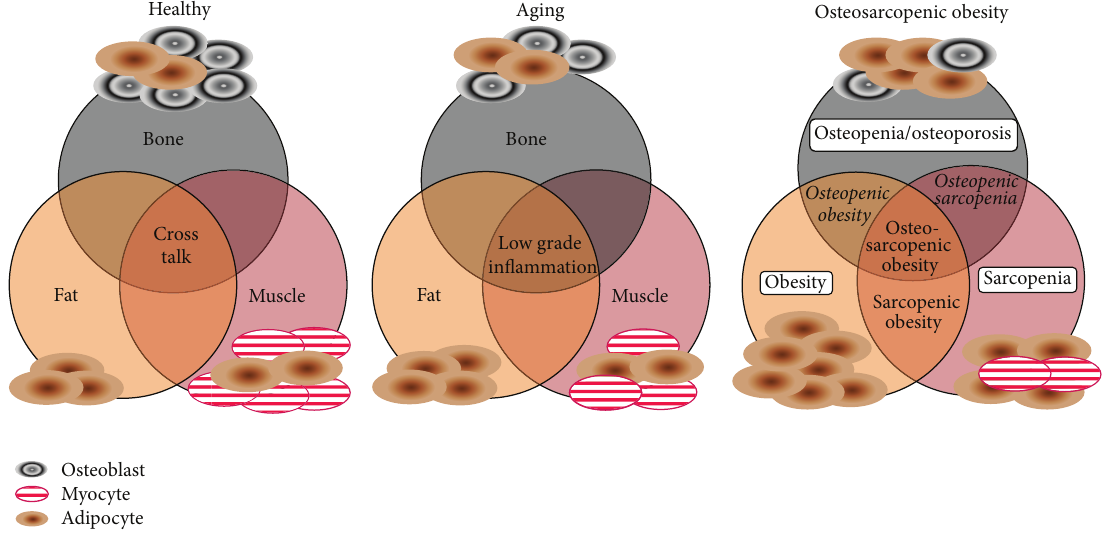
Figure 2: Conceptual model of bone, muscle, and fat tissues in healthy and diseased states: osteosarcopenic obesity is the most advanced stage resulting from aging or other compromised impairment in bone, muscle, and adipose